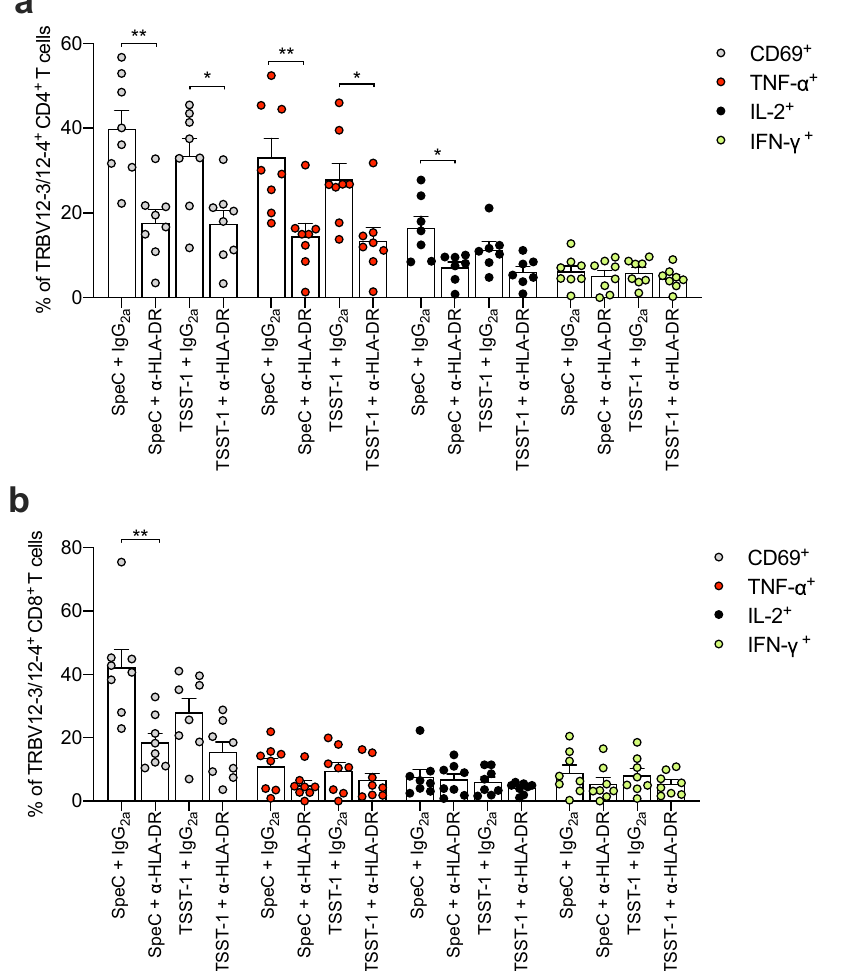
Fig. 5 SpeC and TSST-1 trigger TRBV12-3/12-4 + CD4 + and CD8 + T cells via HLA-DR. a , b Frequency of CD69 + (gray fi lled circles), TNF- α + (red fi lled circles), IL-2 + (black fi lled circles), or IFN- γ + cells (green fi lled circles) among TRBV12-3/12-4 + CD4 + ( a ) or CD8 + T cells ( b ) from human PBMCs pretreated with anti-human HLA-DR or an isotype control antibody (IgG 2a ) and then stimulated for 24 h with SpeC or TSST-1. Each dot represents one donor. Data are shown as mean ± SEM. * p < 0.05, ** p < 0.01. One-way ANOVA with Tukey ’ s post-hoc